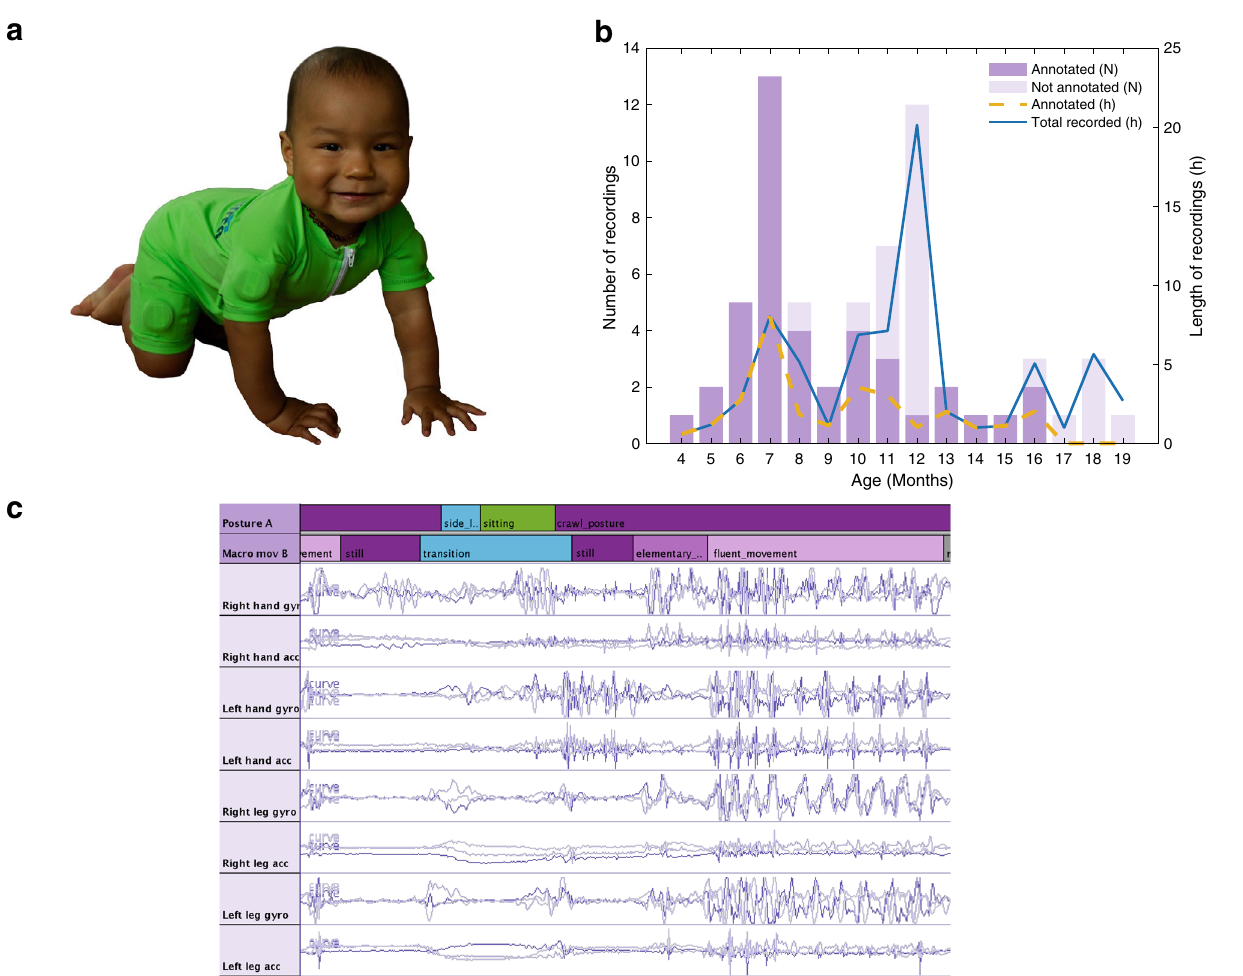
Fig. 1 Overview of the MAIJU wearable, infant cohort, and recording data. a A 10-month-old subject crawling at home with the MAIJU jumpsuit, equipped with movement sensors in the proximal pockets of each limb. The photograph has been published with informed parental consent. b Summary of the infant cohort ( N = 59 infants, N = 64 recordings) recorded in the present study. Bars depict a monthly breakdown of the numbers of infants with MAIJU recordings with vs without synchronized annotated video recordings, as well as the total length of data available for each age. c An example recording in the annotation software showing 20 s of the raw 24-channel data obtained from the four MAIJU sensors, as well as the respective human annotations for postures and movements shown in the bars above the signals, colored according to the motor ability categories shown in Fig. 5a. Note the frequent transitions in posture and movement